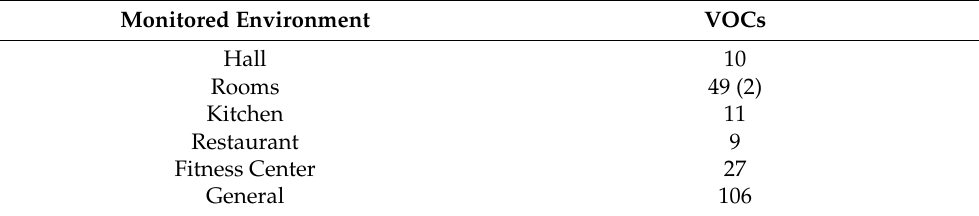
Figure 8. Concentrations of VOCs (ppb) detected in the kitchen across the whole period of analysis. Table 4. Descriptive statistics for the different contaminants monitored, in each environment included.